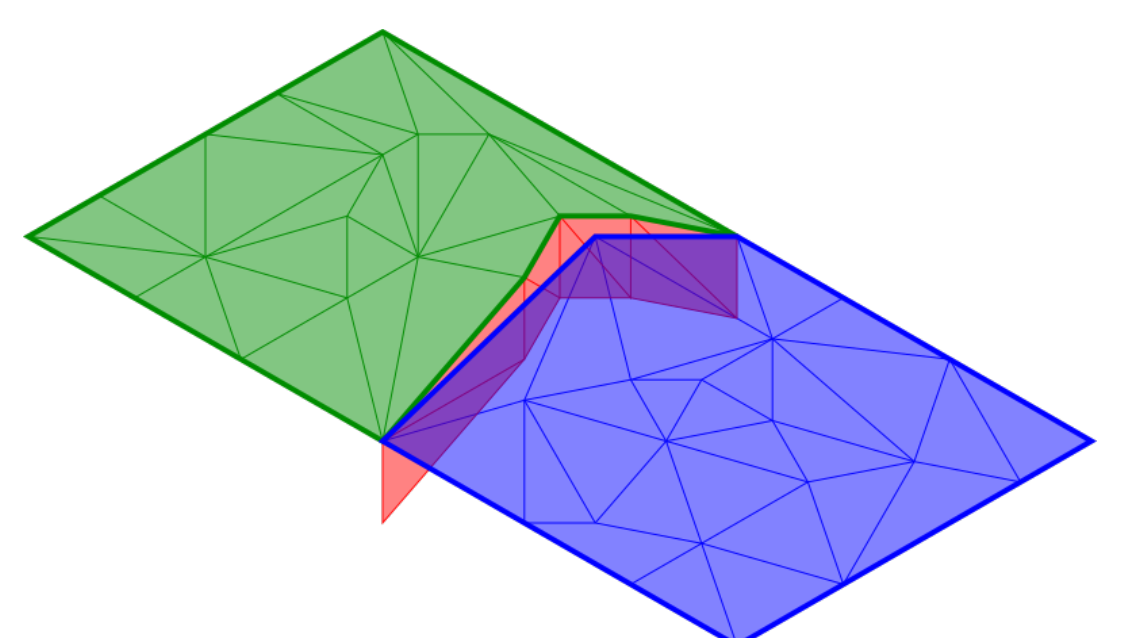
Figure 2. A strip of vertical triangles (also referred to as a skirt ), such as the one depicted in red, can be added between neighboring TINs to hide discrepancies at their borders. In this work, we aim at avoiding the use of these techniques within the same LOD by forcing the borders of the tiles to be